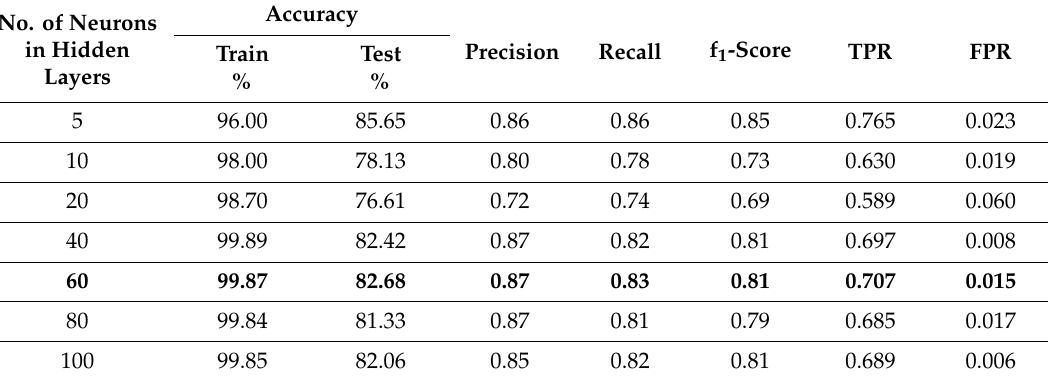
Table 7. Multi-class classification performance results using 122